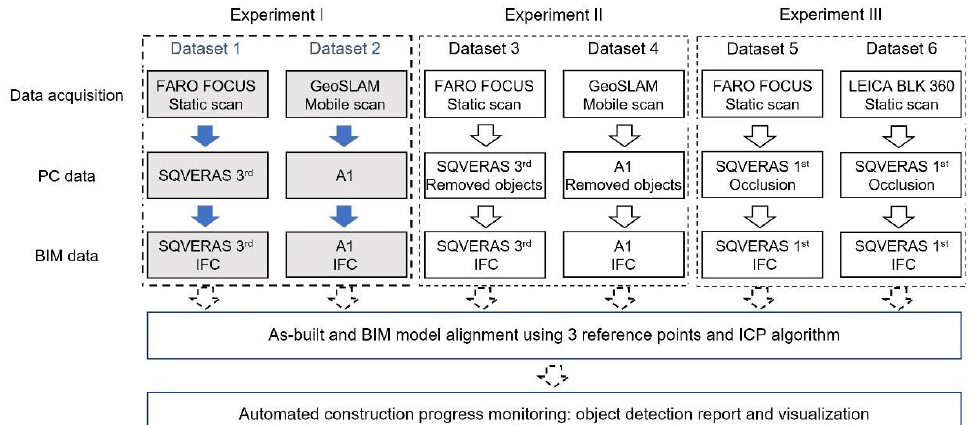
Figure 1. Research methodology.